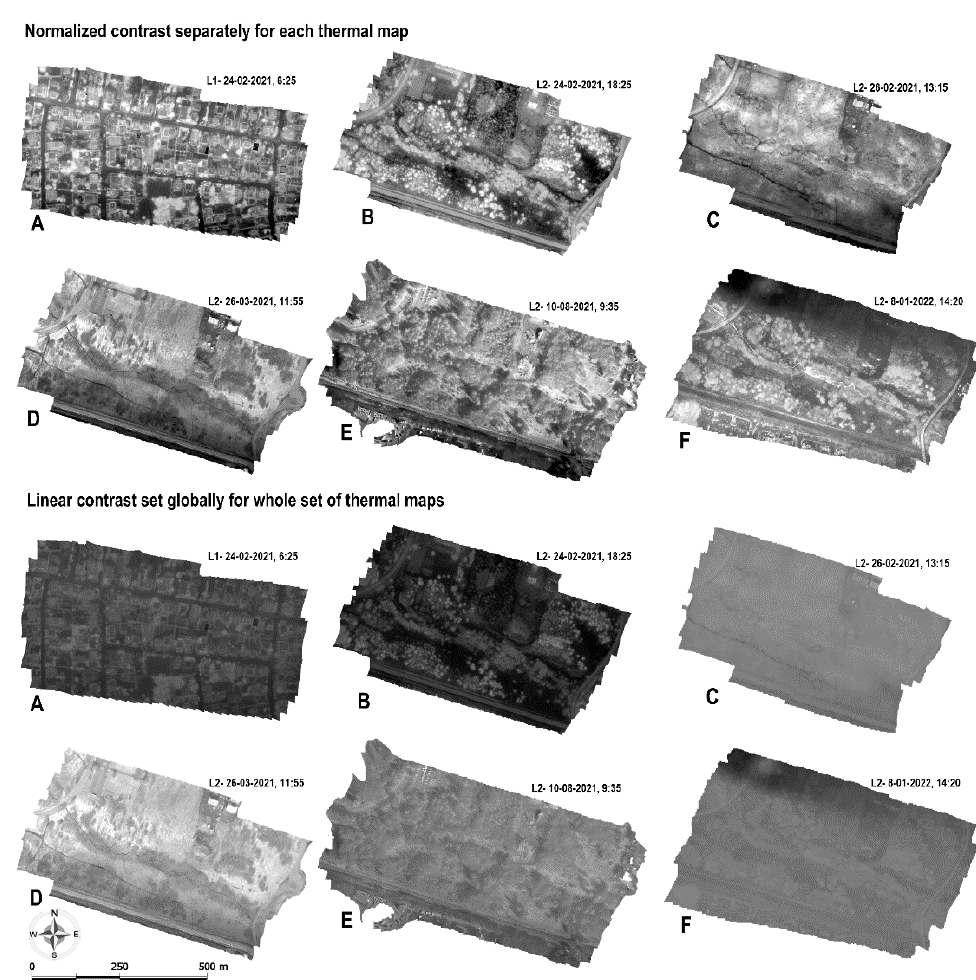
Figure 5. Thermal orthophotomaps computed for the sets of images taken with the E10T camera using Agisoft Metashape software for the location L1 (1 term, subfigure ( A )) and locations L2 (five terms, subfigures ( B – F )). Orthophotomaps are presented in two ways: using the contrast normalized for each orthophotomap (upper part of the illustration) and linearly defined contrast for full variation DN values of the orthophotomap set (lower part of the illustration). The pictures were taken from the height set to 100 m AGL. Orthophotos are oriented in real geographic directions.